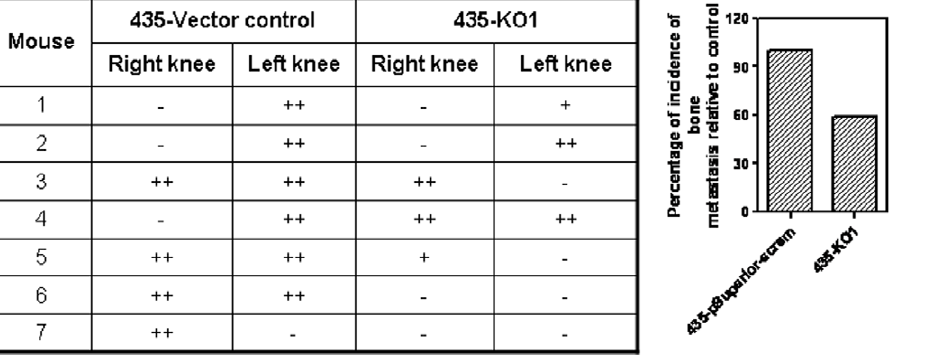
Figure 7. Active Hh signaling in the tumor cells is vital to their ability to cause osteolysis. MDA-MB-435 tumor cells were injected into the left cardiac ventricle of athymic mice; mice were euthanized 4–6 weeks later and radiographically imaged and assessed for osteolysis at the tibio- femoral junction. As represented in the Table, cells that were silenced for GLI1 expression showed an attenuated ability of osteolysis. The percent incidence of osteolysis is depicted in the adjacent